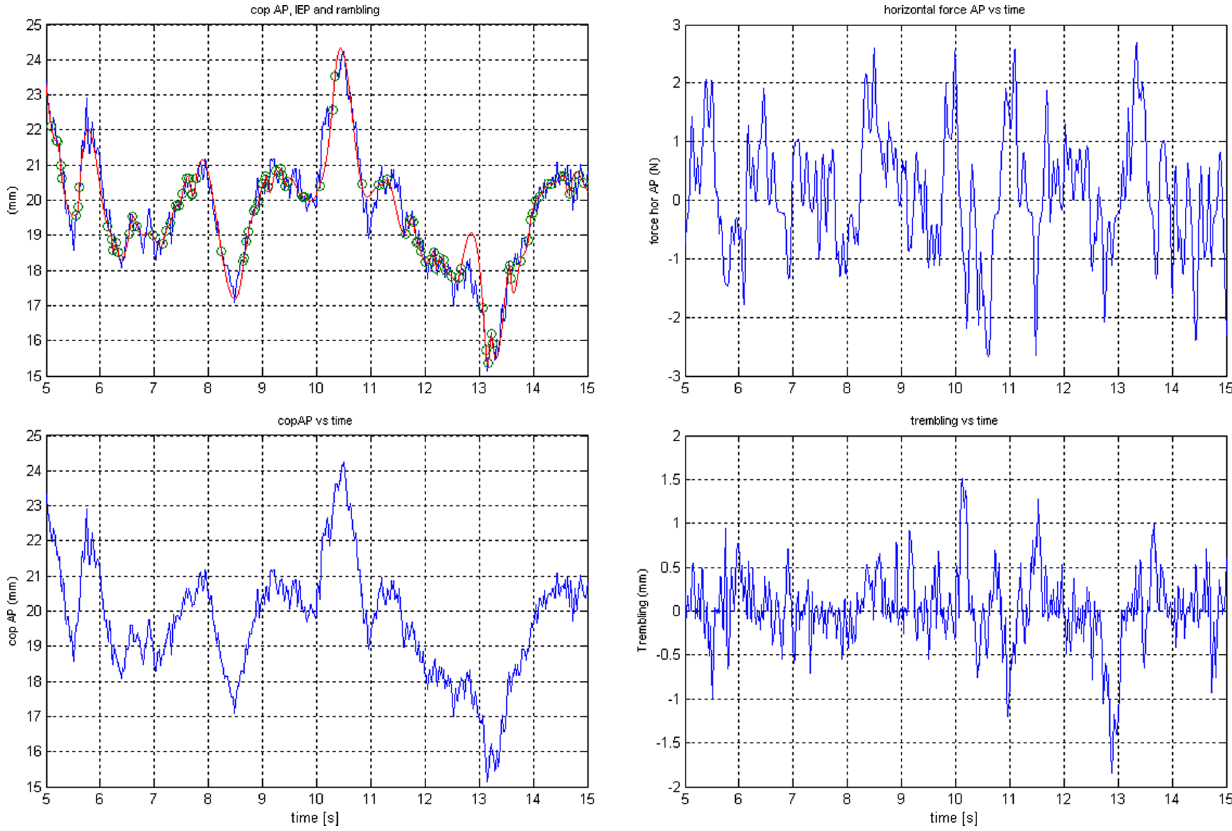
Figure 3. Representative center of pressure, rambling and trembling trajectories of a single subject along the anterior-posterior (AP) axis.